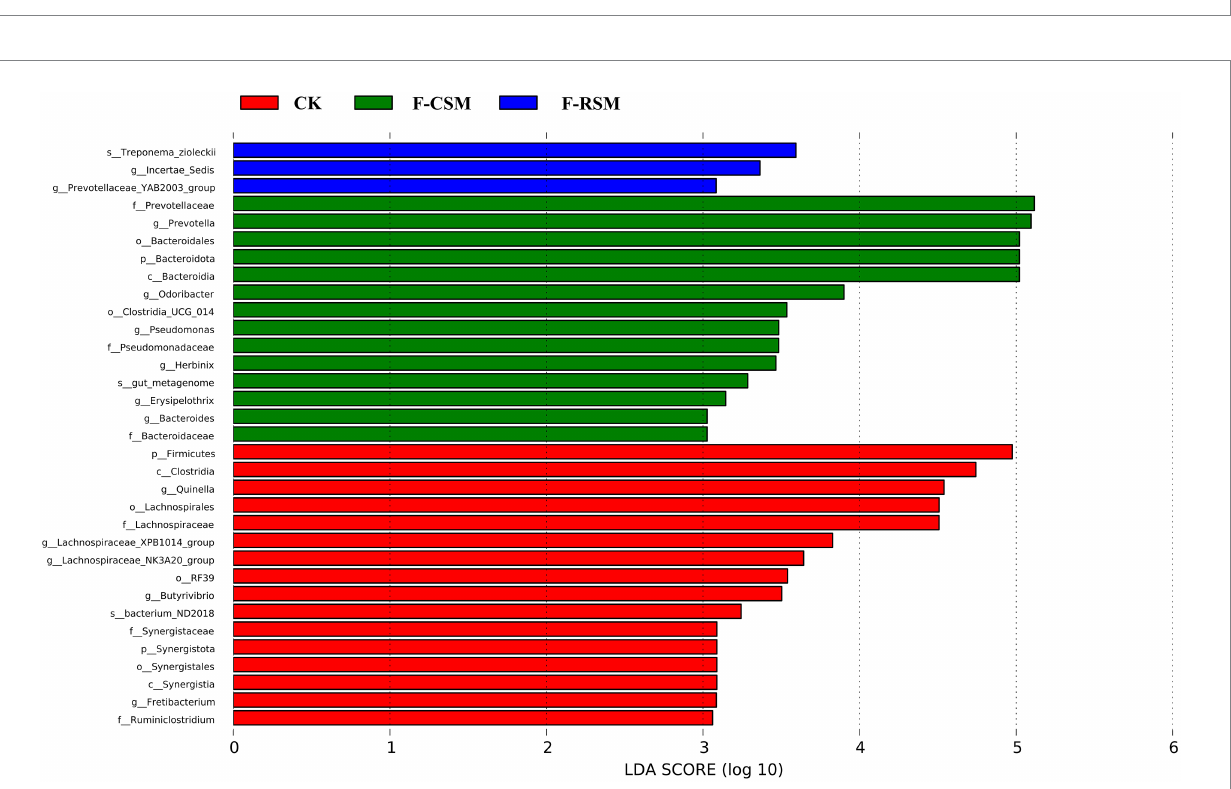
FIGURE 5 Effect of potential biomarkers was defined by LEfSe at Hu sheep rumen liquite (log 10 ); CK, non-fermented group; F-CSM, fermented Cotton seed meal TMR; F-RSM, fermented Rapeseed meal